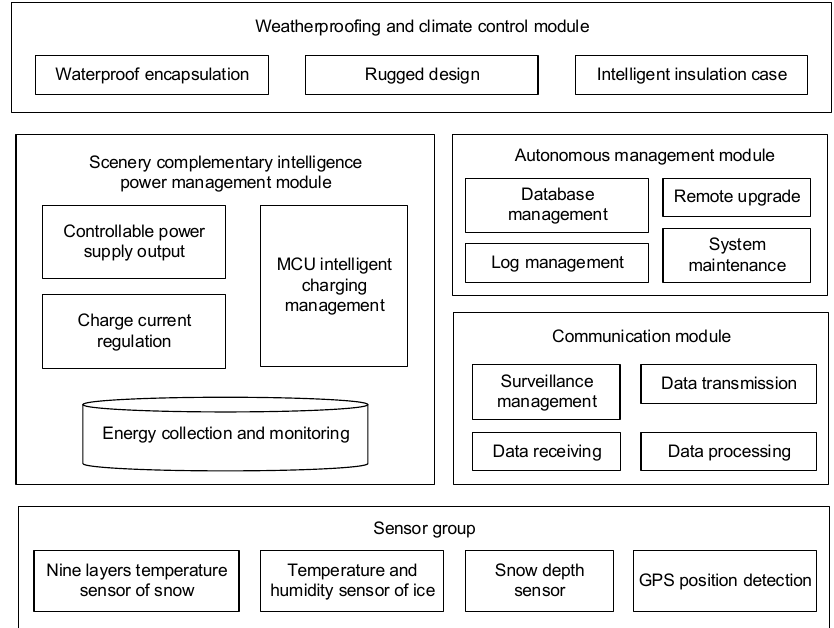
Figure 1. The architecture of the WSOOP.